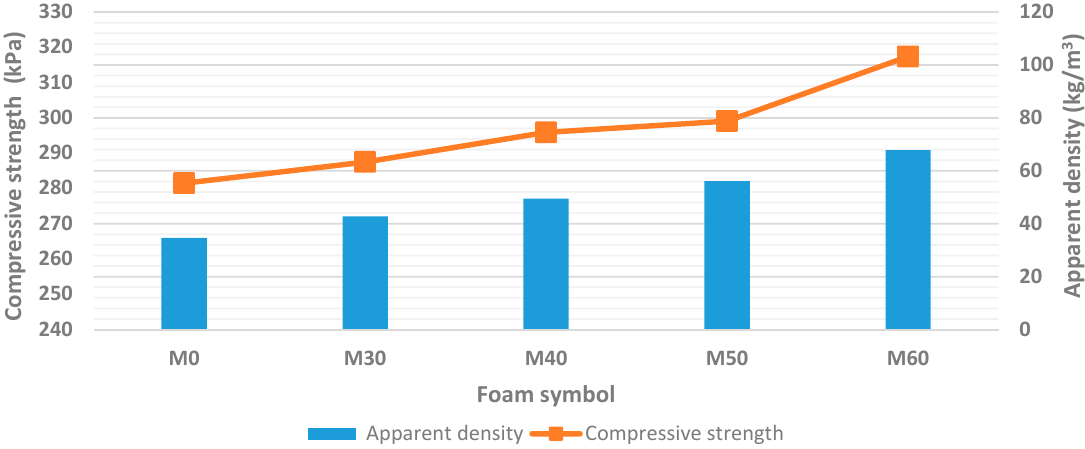
Figure 6. Dependence between content of rapeseed cake, apparent density and compressive strength in the parallel direction to foams rise.